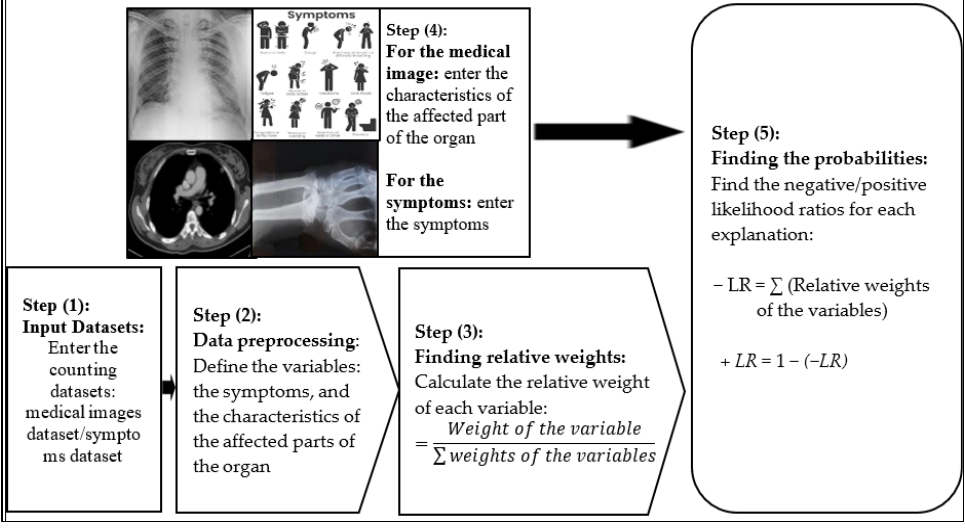
Figure 3. Using the interpretability-based model to train the datasets.